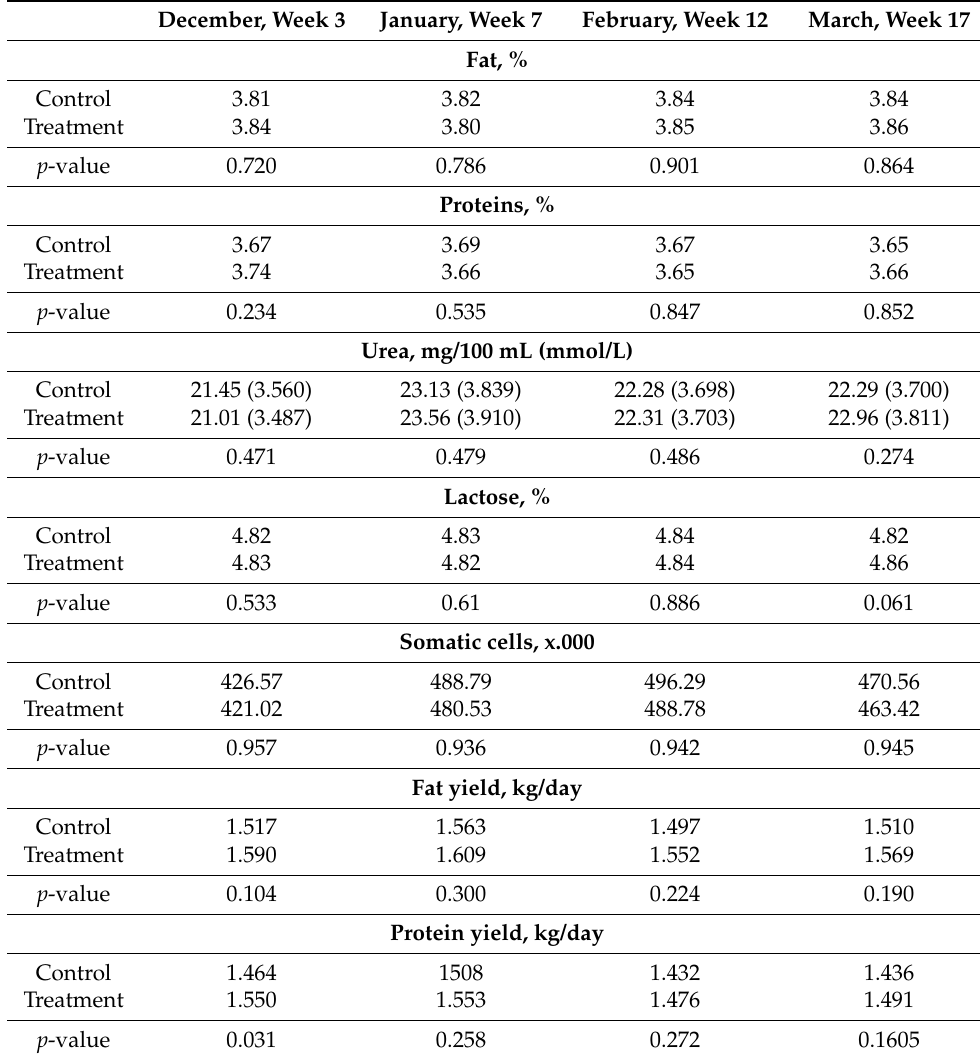
Table 3. Production performance: milk quality